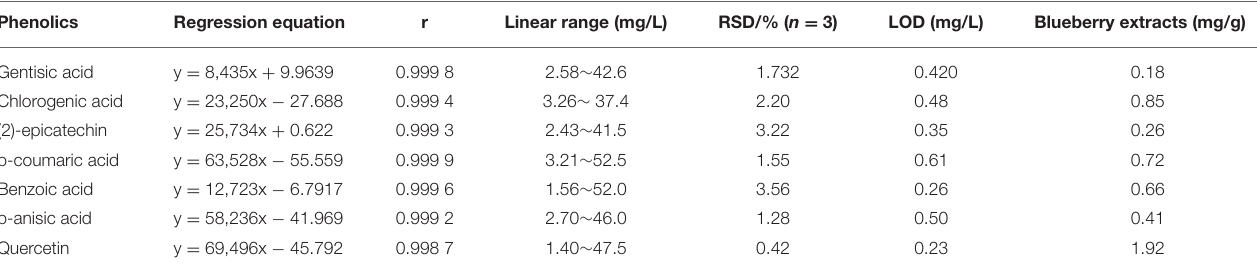
r, correlation coefficient; RSD, relative standard deviation (RSD); and LOD, limit of detection. Regression equation was calculated by using peak area as Y (vertical axis), and the concentration as X (horizontal axis). Each compound was measured according to the standard curve by substituting corresponding standard curve